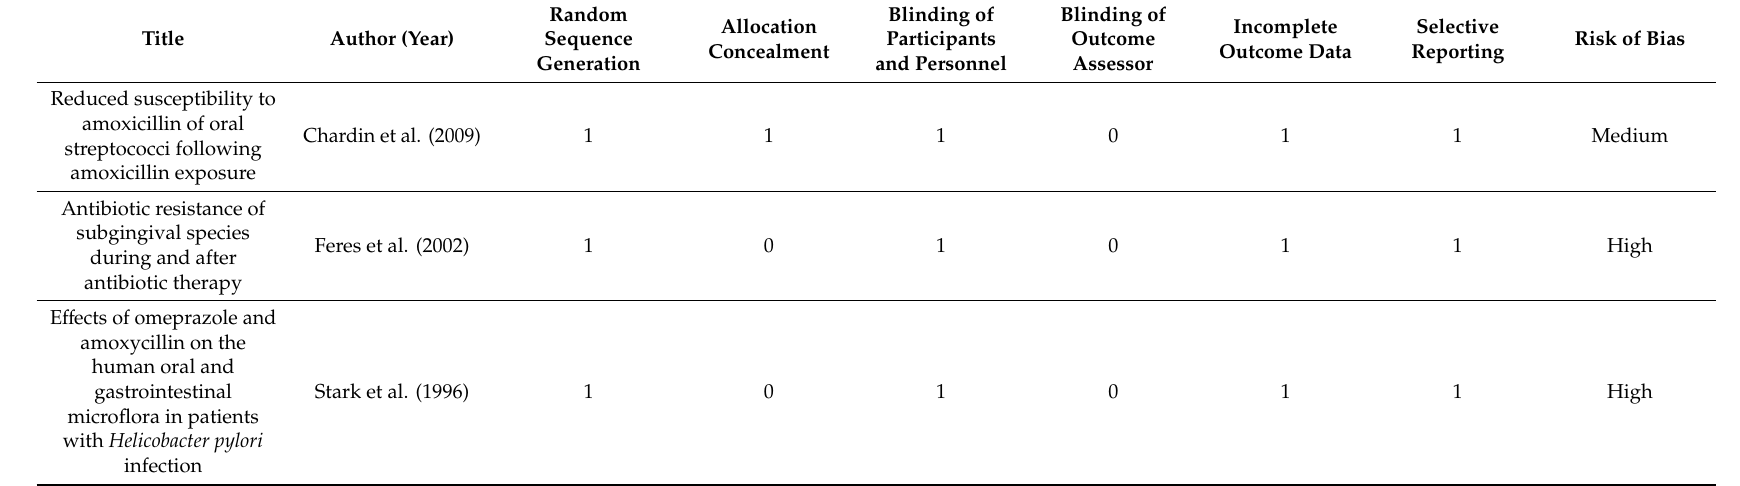
Table 2. Review of authors’ judgments on the sections of the Newcastle–Ottawa quality assessment scale for case control studies for each included